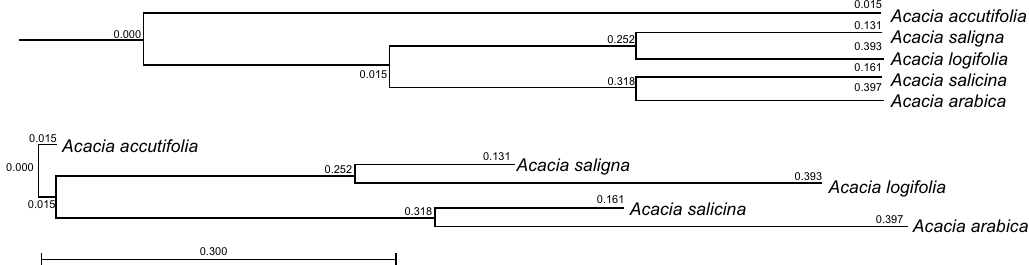
Fig. 3. Hierarchical analysis showing genetic relationship among the of five Acacia spp. based on data generated using 8 ISSR